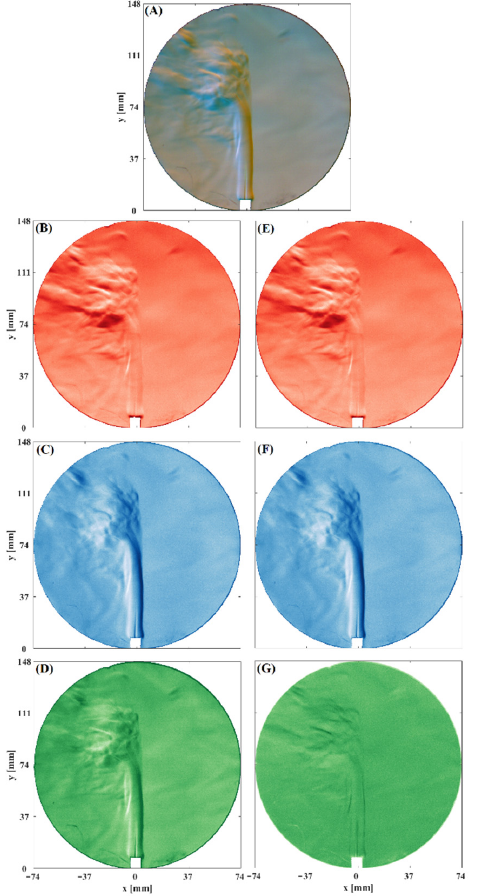
Figure 3. Flame and perturbed convective fluid flow of a pencil soldering iron. ( A ) RGB image. ( B ) Uncorrected horizontal sensitivity Schlieren image, ( C ) Uncorrected vertical sensitivity Schlieren image, ( D ) Uncorrected shadowgraph image, ( E ) Corrected horizontal sensitivity Schlieren image, ( F ) Corrected vertical sensitivity Schlieren image, ( G ) Corrected shadowgraph image.